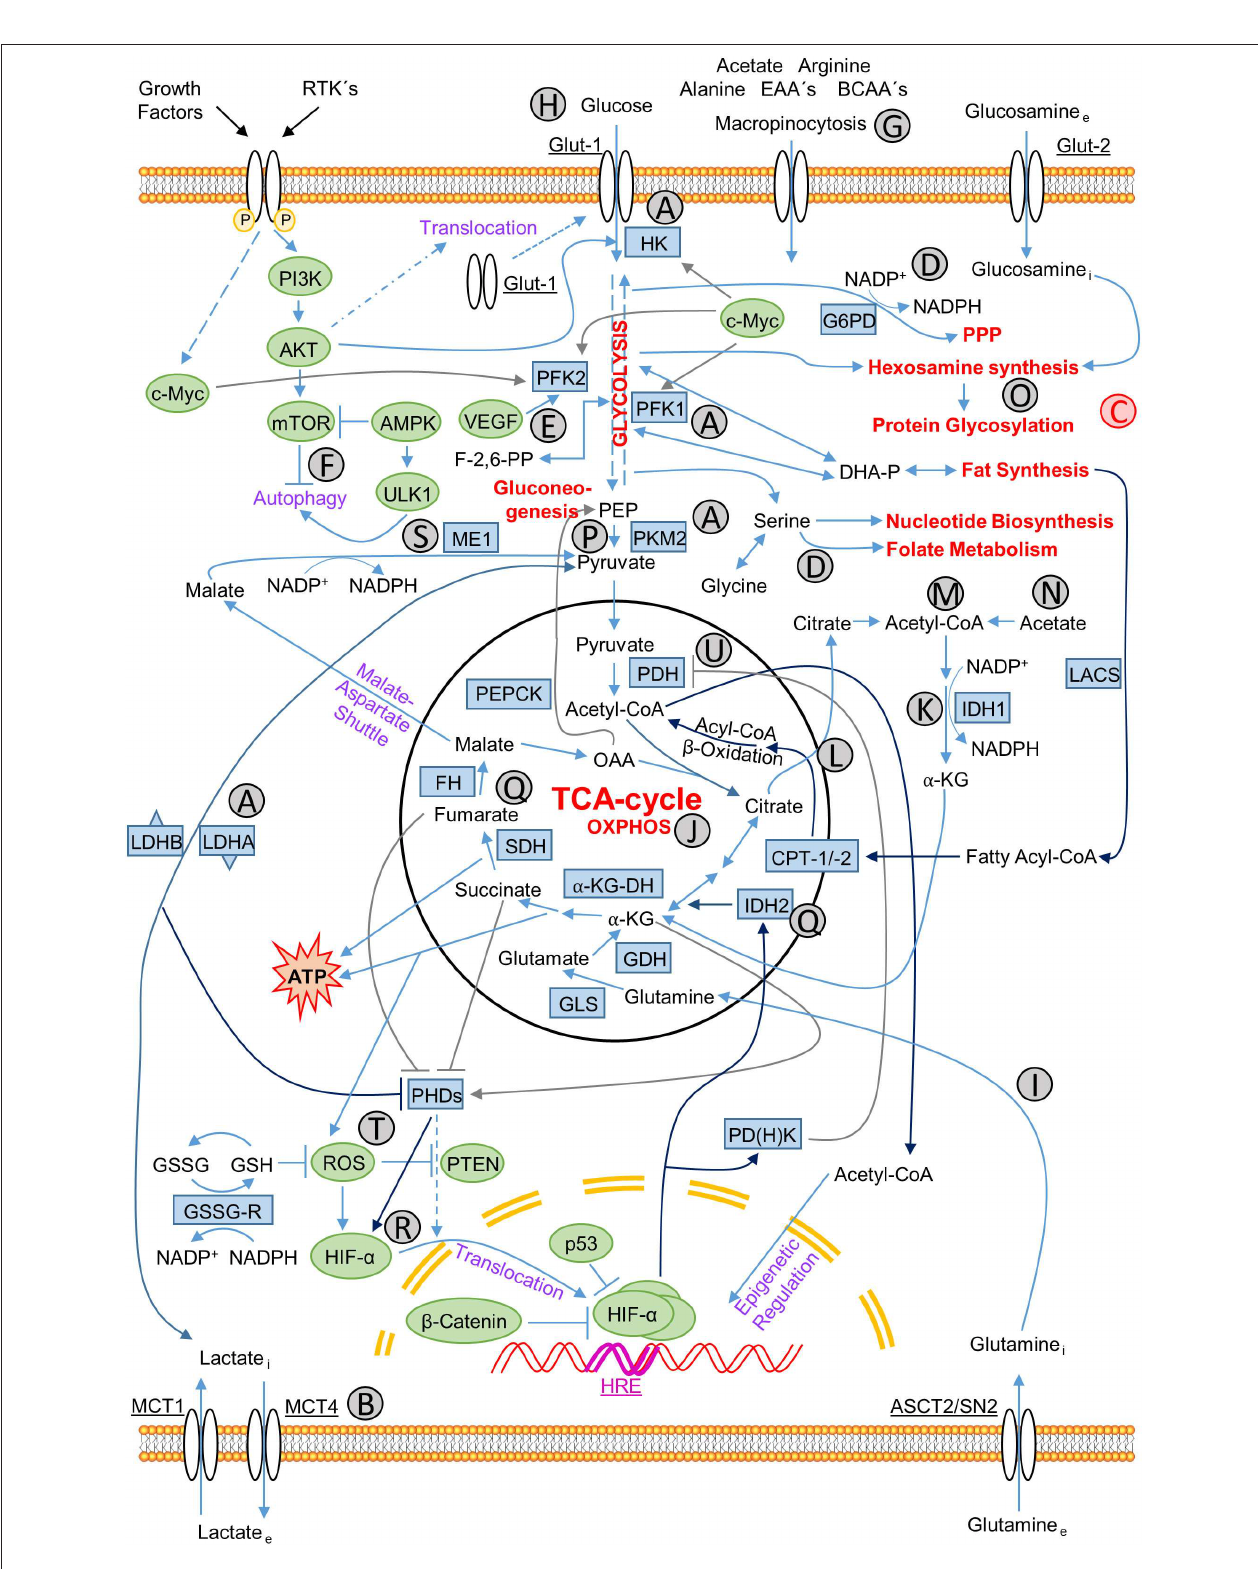
FIGURE 2 | Metabolic-regulatory relationships in cancer cells. Relationships between influxes and effluents of metabolites in cancer cells, individual metabolic pathways of energy production and production of precursor molecules for biosynthesis of lipids, nucleotides, and macromolecules for membranes and organelles,